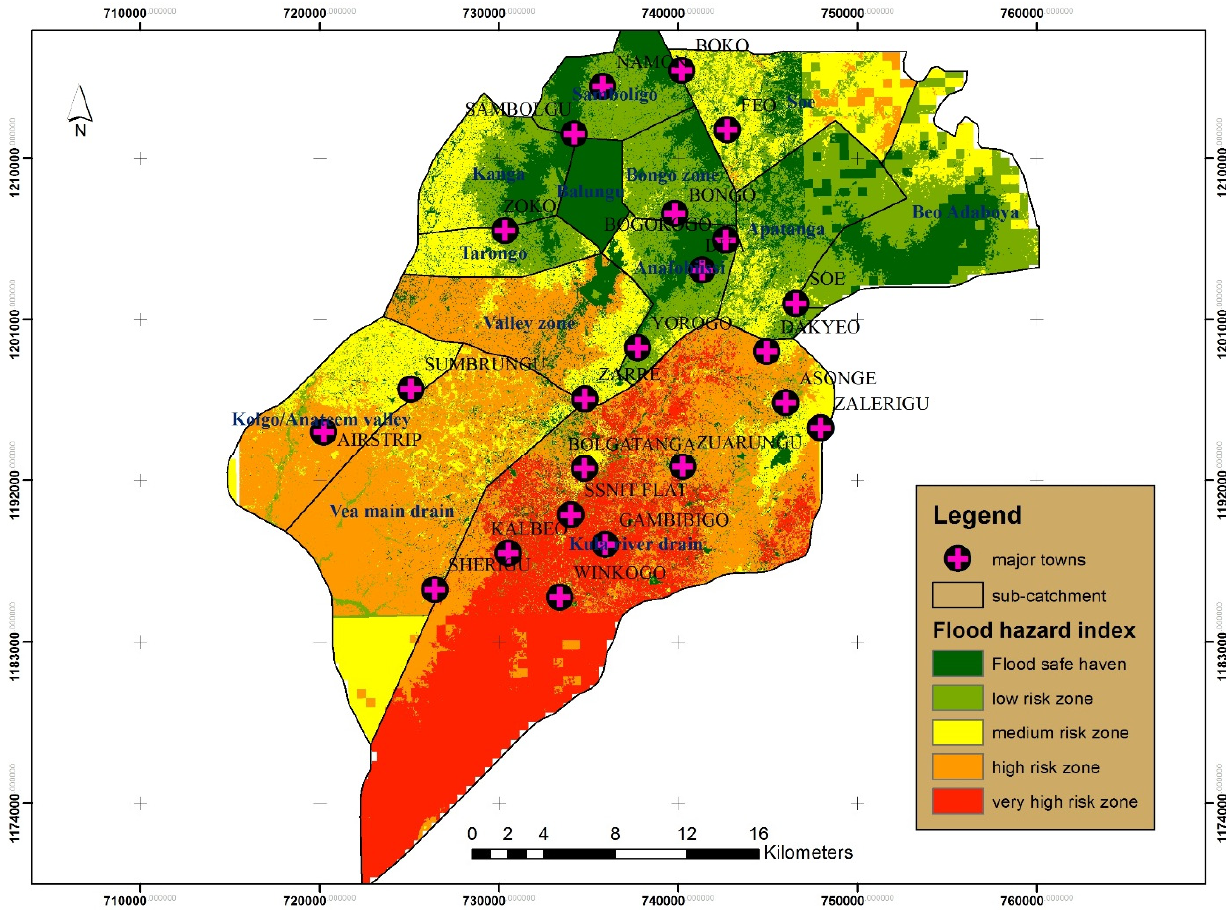
Figure 10. Flood safe havens in Vea study